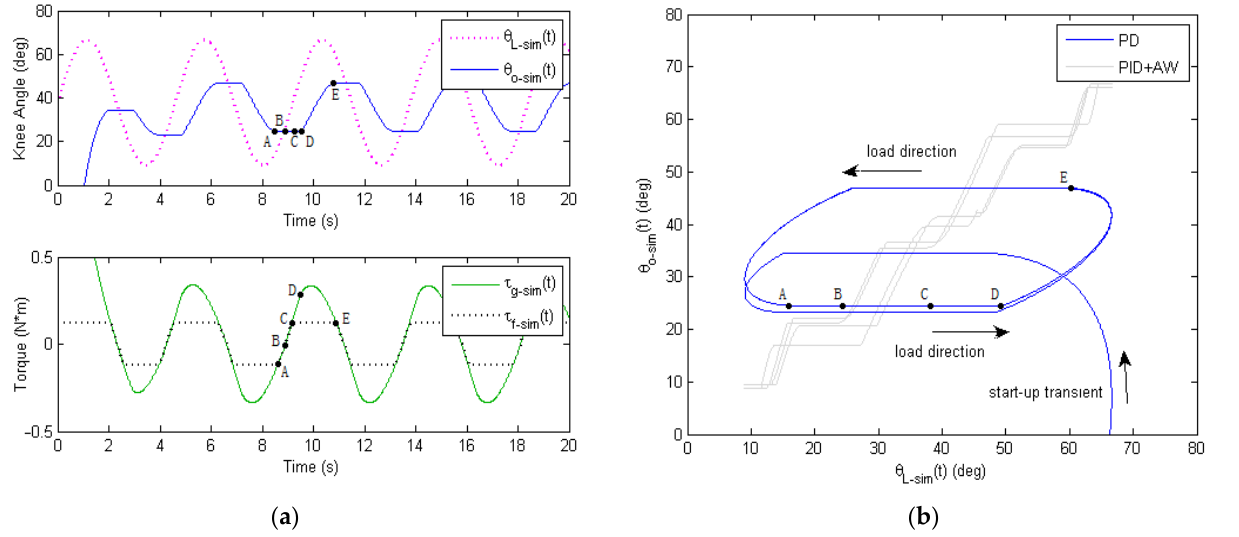
Figure 7. Position tracking performance of the inner-loop digital servo controller with Bowden cable friction ( 𝜇 = 0.5 , 𝜙 = 90 𝑜 ) and gear-reducer backlash of 𝐵 𝑔 = ±2 o . ( a ) Simulated sinusoidal response of the soft knee exoskeleton. ( b ) Simulated relationship of the reference input 𝜃 𝐿−𝑠𝑖𝑚 (𝑡) and output displacements 𝜃 𝑂−𝑠𝑖𝑚 (𝑡) of the exoskeleton knee joint.